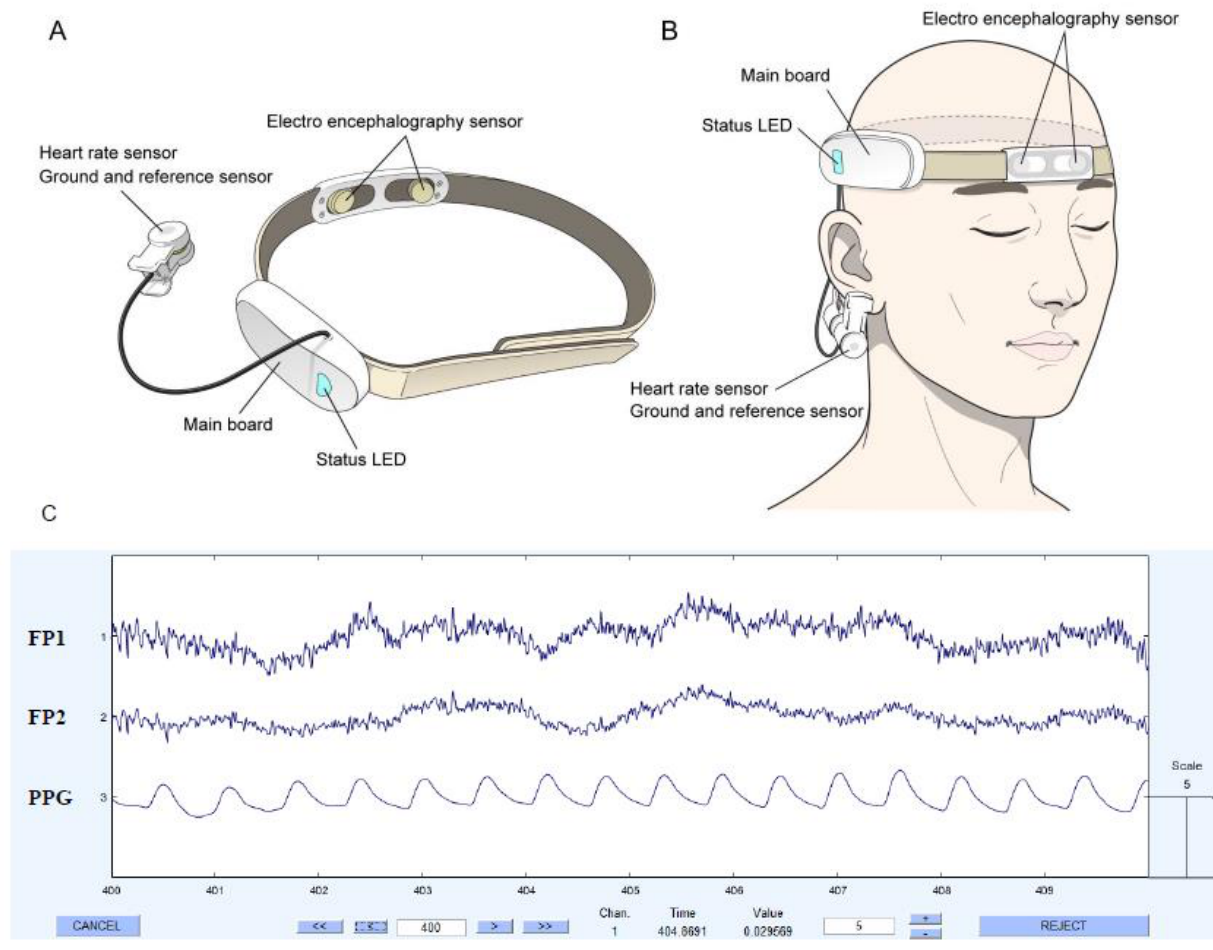
Figure 1. ( A ) Profile of the wearable device. ( B ) The device is worn on the head. ( C ) Captured the raw signals displayed on MALTAB software. EEG; Electroencephalography, PPG; Photoplethysmography.